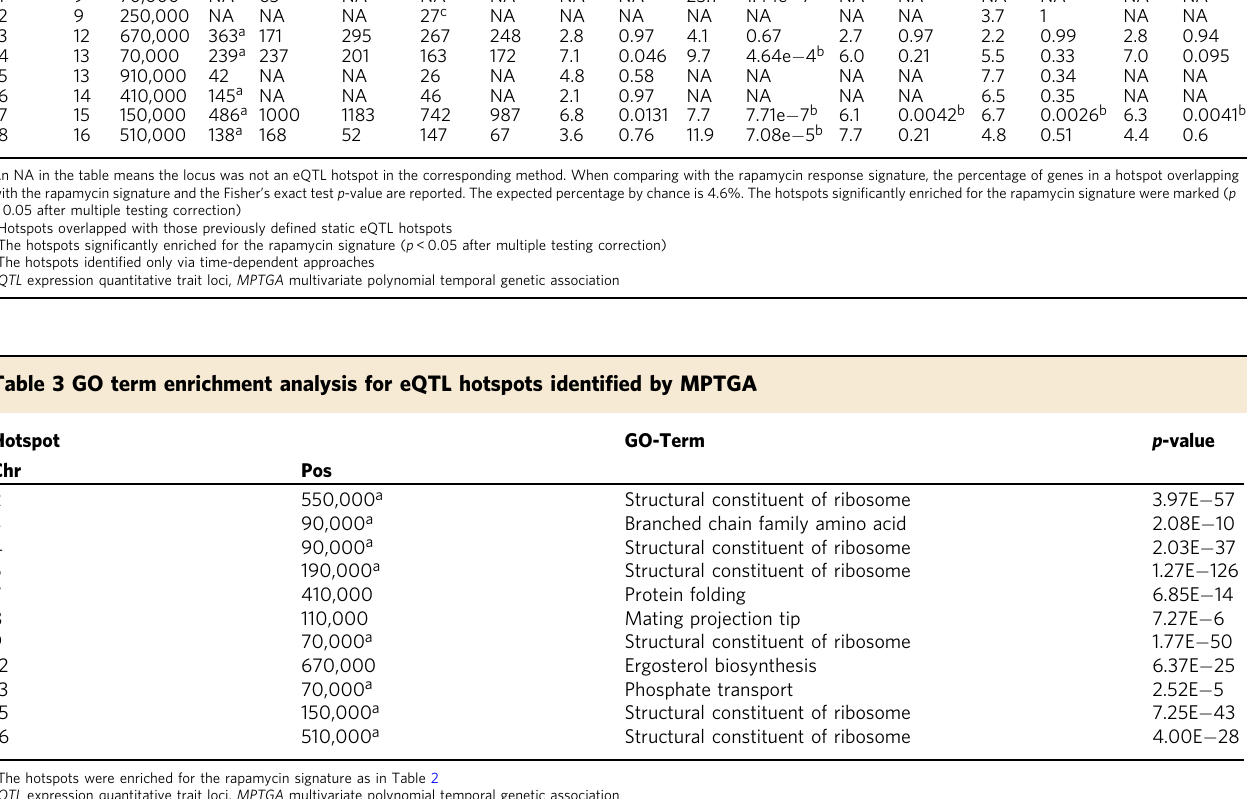
(Table 4, the distribution of BIC difference between causal model M1 and the second best fi t models is shown in Supplementary Fig. 13). RRD1 is an activator of PP2A , a gene involved in G1 phase progression. PP2A is required for rapamycin response 38 ,